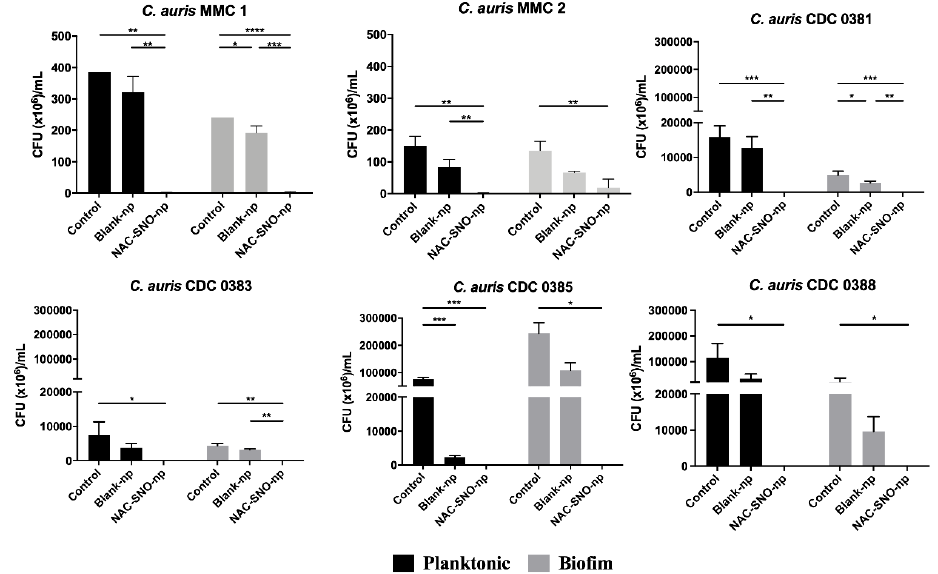
Figure 4. Planktonic and biofilm C. auris were incubated for 48 h and treated with NAC-SNO-np (10 mg/mL). CFUs were counted after 24 h. Statistical analysis was performed by one-way Anova with Tukey’s multiple comparison test. * p < 0.05, ** p < 0.01, *** p < 0.001, **** p <